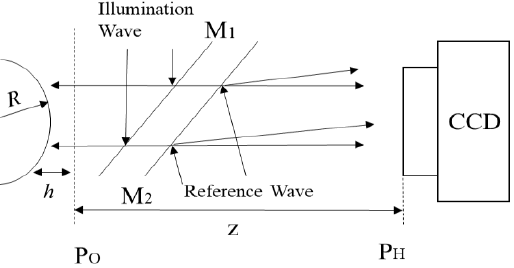
Figure 1. Simulation setup in phase-shifting digital holography with the tilted reference wave.